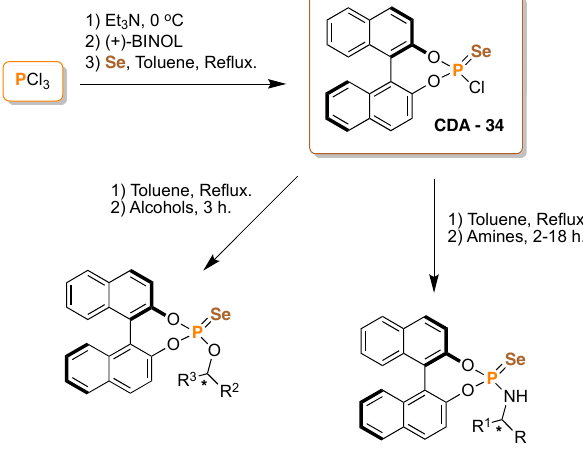
Scheme 28. Three-component reaction for chiral discrimination of selenide amines by 77 Se { 1 H} NMR